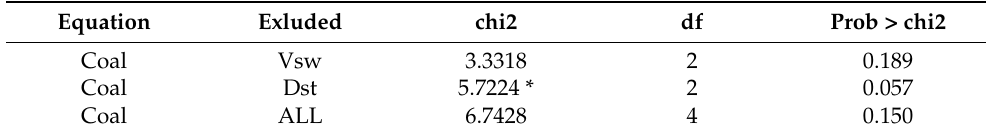
Table 10. Space weather and coal consumption rate of fossil power plants.